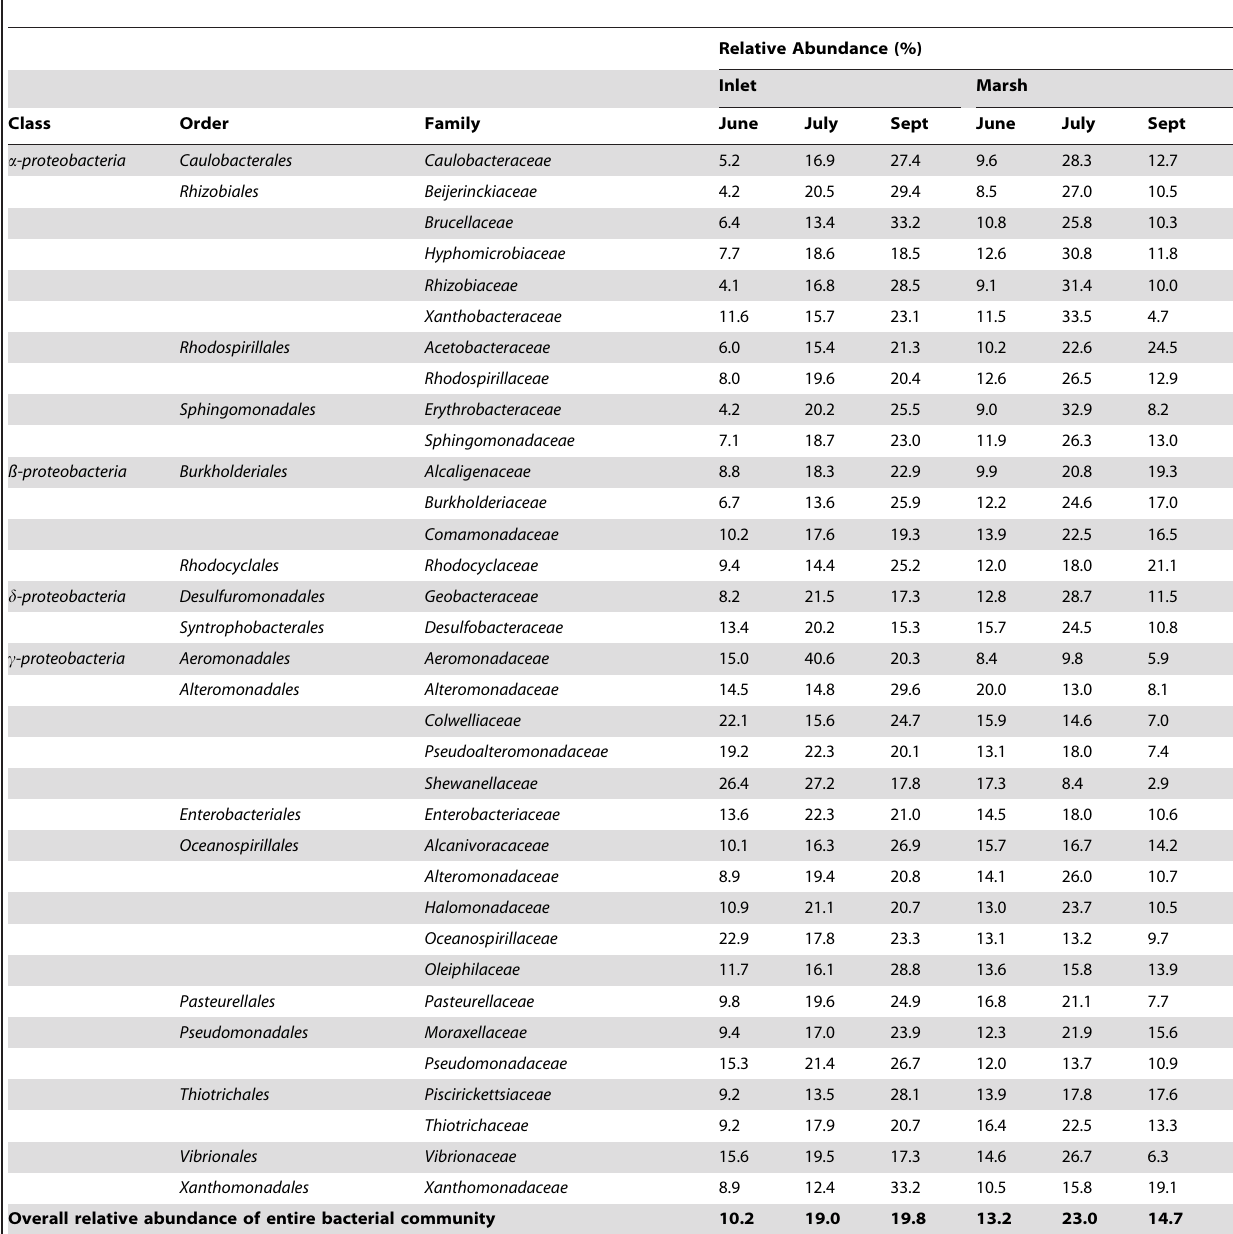
Table 5. Relative abundance (%) of families of Proteobacteria known to contain hydrocarbon-degrading species.